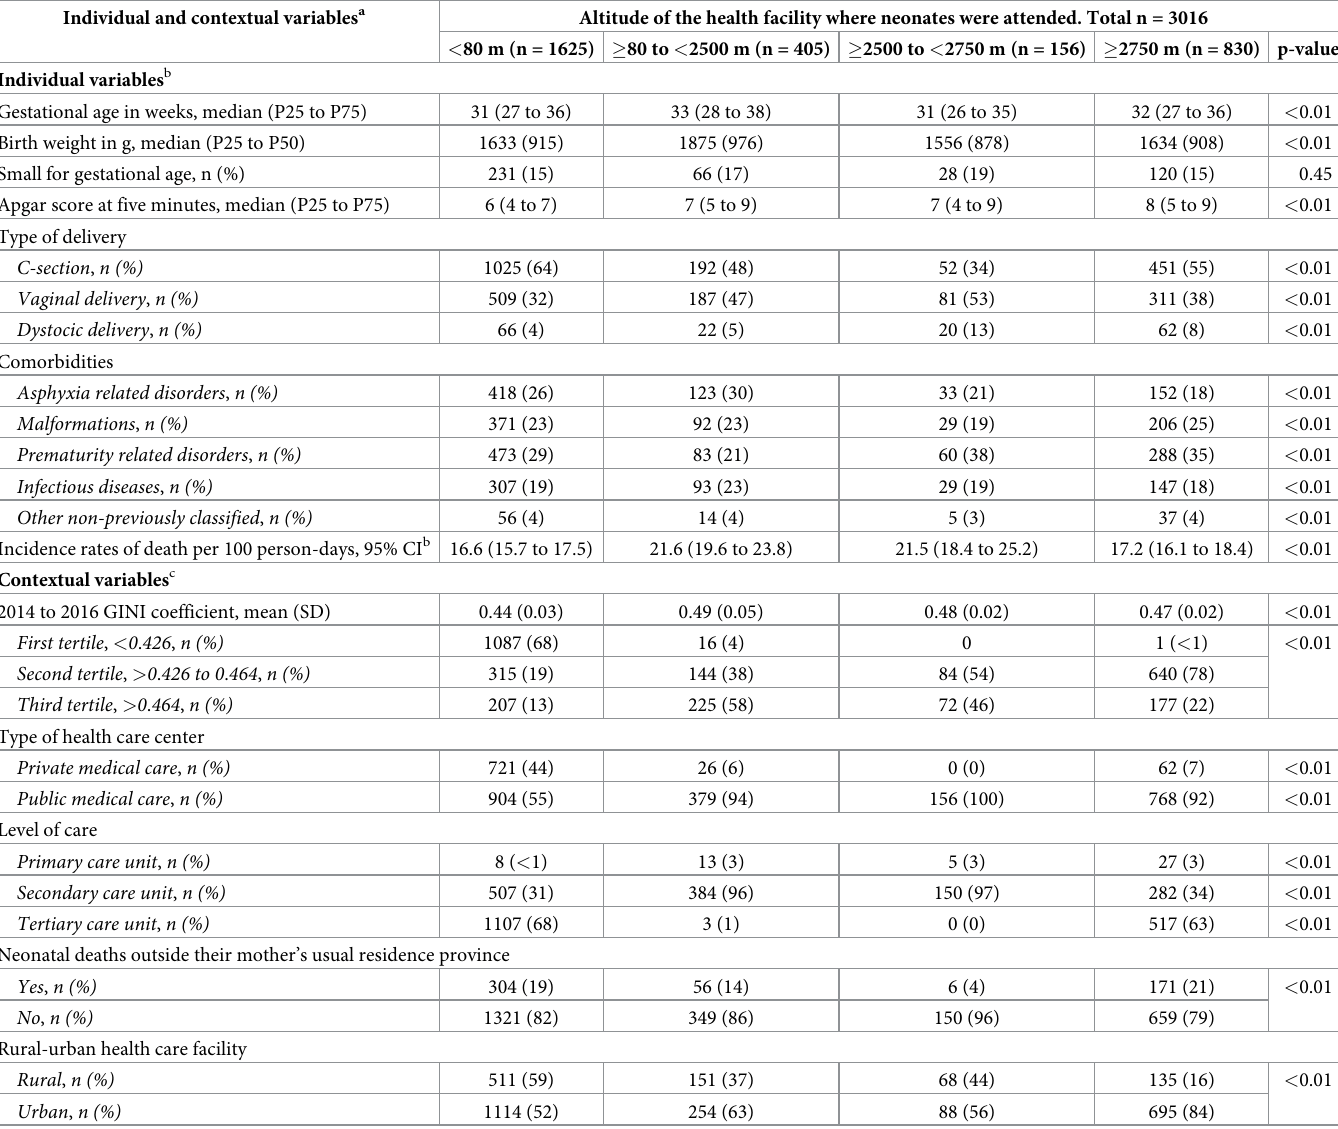
Table 1. Differences on individual and contextual variables of the study population across categories of altitude of the health facility where neonates were attended. Individual and contextual variables a Altitude of the health facility where neonates were attended. Total n =